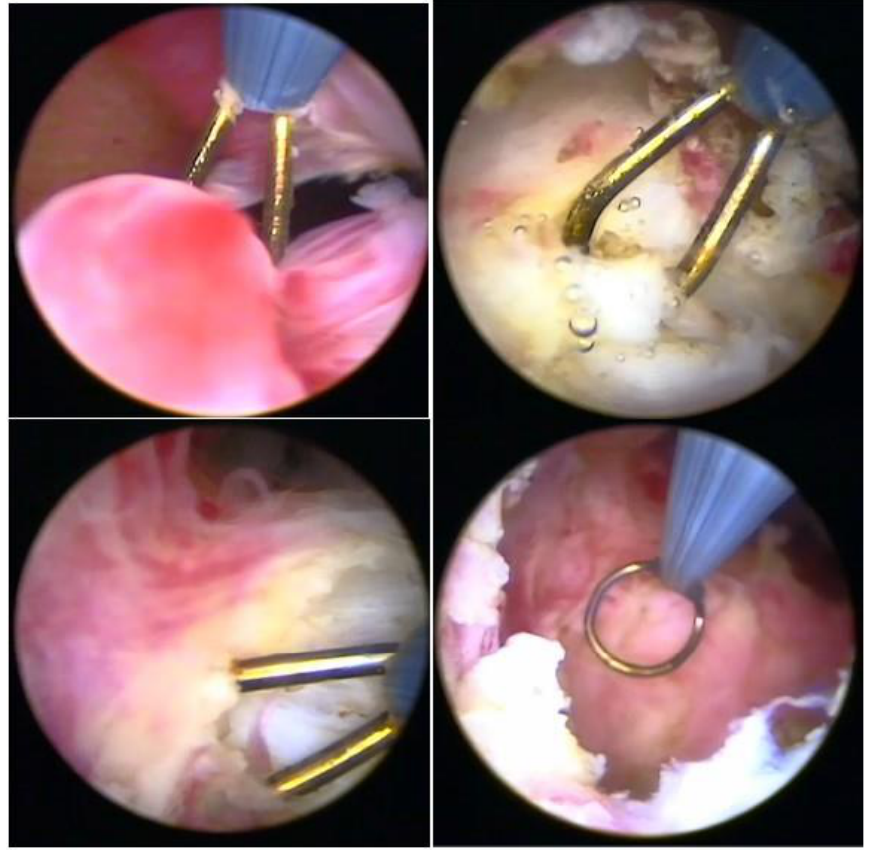
Figure 8. Office hysteroscopic myomectomy with miniresectoscope.